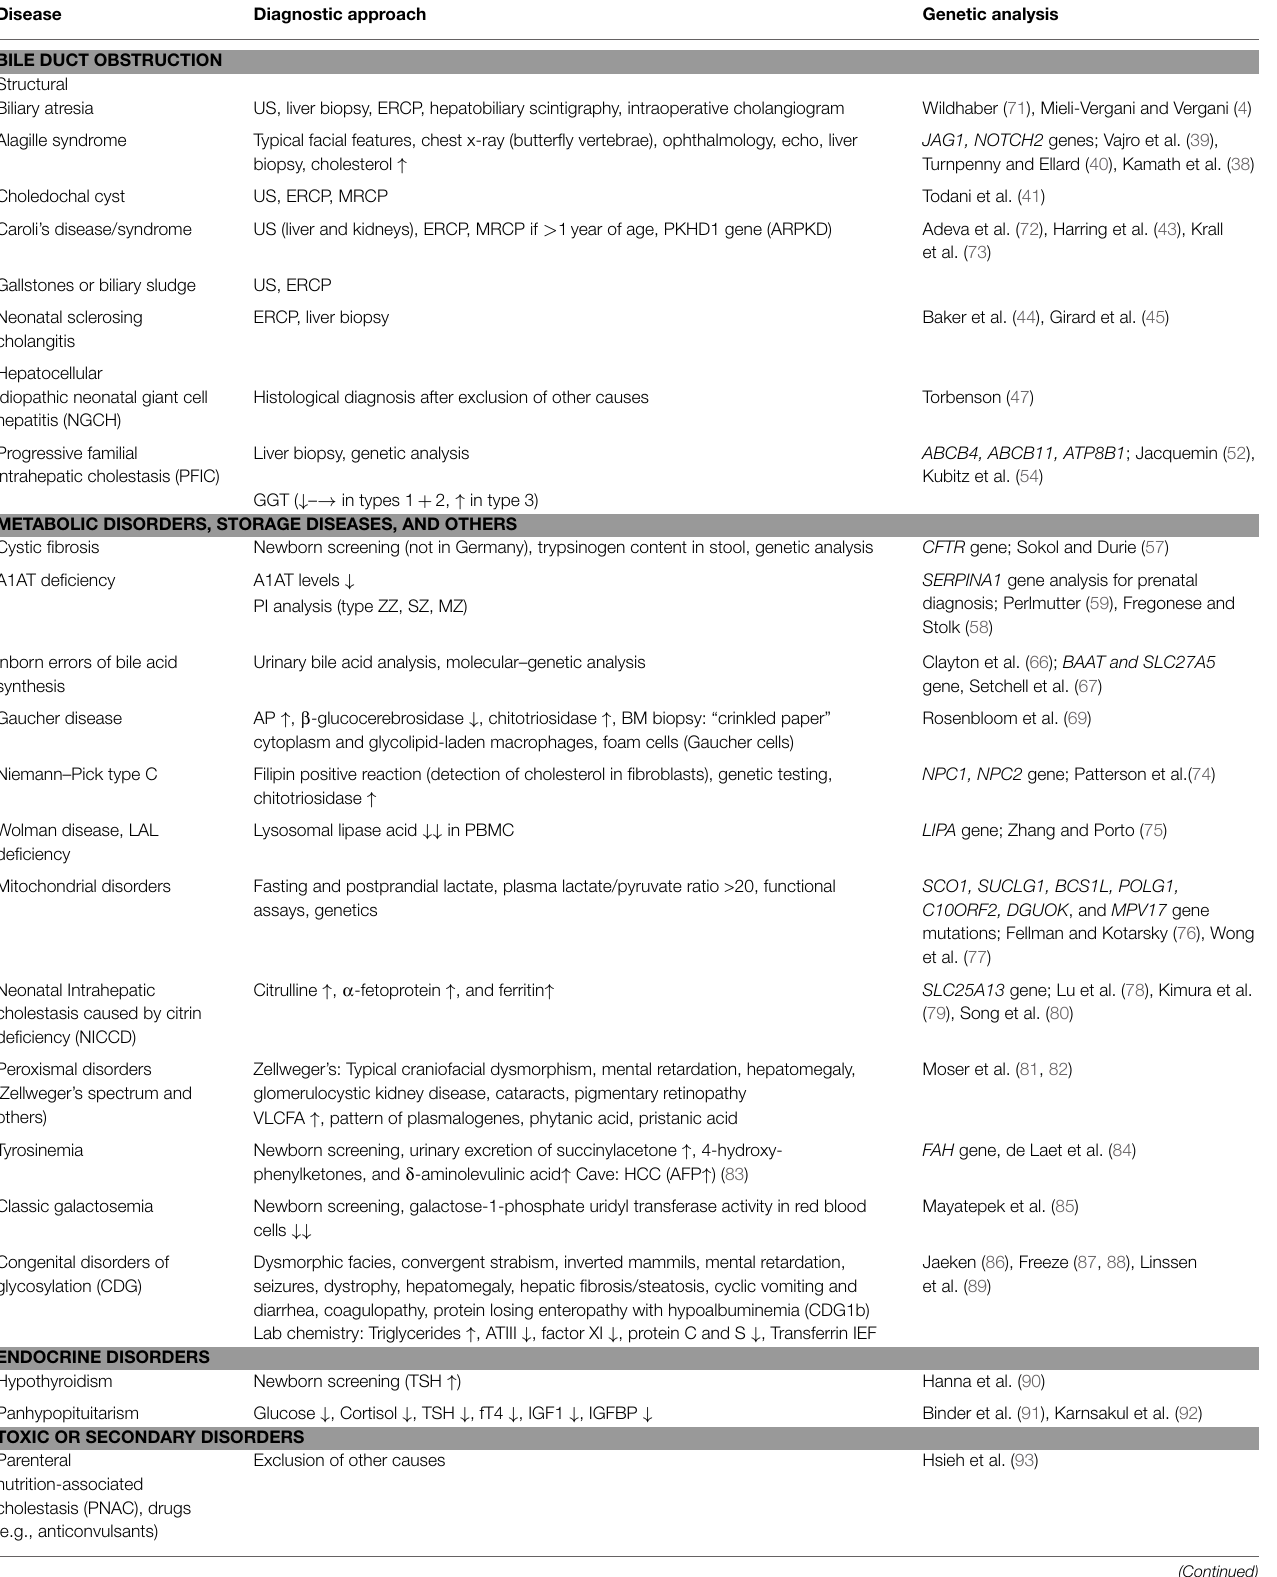
TABLE 1 | Summary of the differential diagnoses and diagnostic approaches